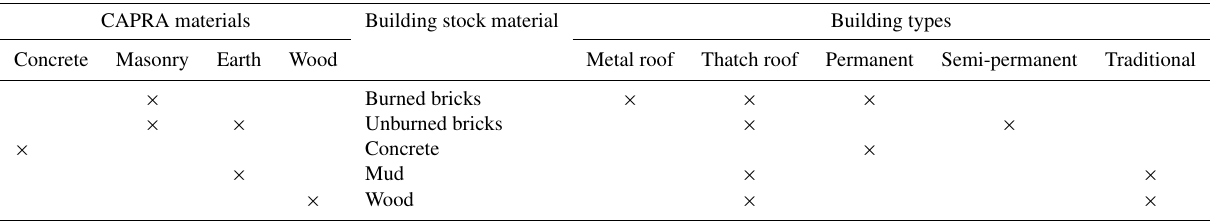
Table 4. Aggregation table of the CAPRA damage curves based on building stock information. CAPRA materials